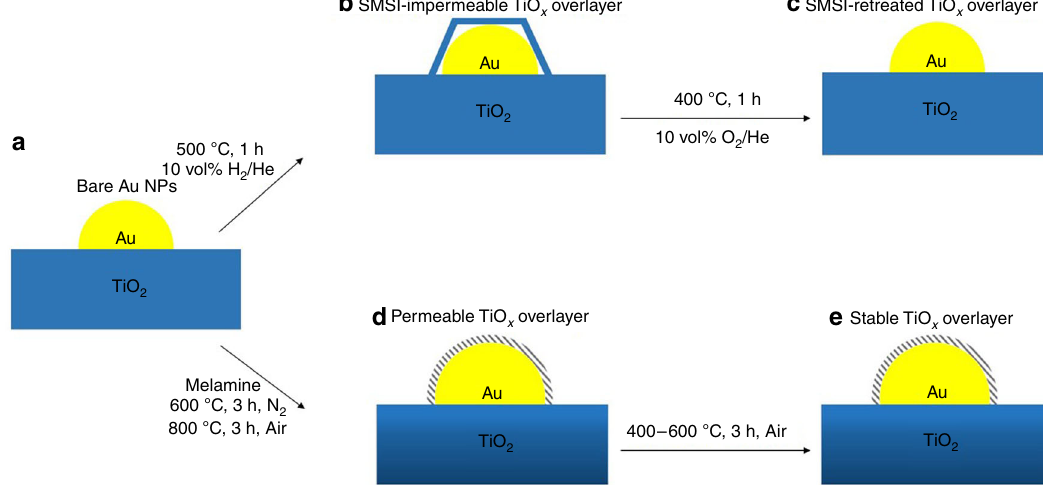
Fig. 6 SMSI and melamine-induced TiO x overlayer structure and behavior. a Bare Au nanoparticles on TiO 2 . b Au/TiO 2 catalyst that forms an impermeable SMSI TiO x overlayer after treatment with 10 vol% H 2 /He at 500 °C. c SMSI TiO x overlayer retreats when exposed to oxidation condition at 400 °C which is almost similar with that in a . d Melamine-modi fi ed catalyst that forms a permeable TiO x overlayer after treatment with N 2 at high temperature (600 °C) followed by treatment with air at 800 °C. e Stable melamine-induced TiO x overlayer under air condition modi fi es the Au NPs catalytic